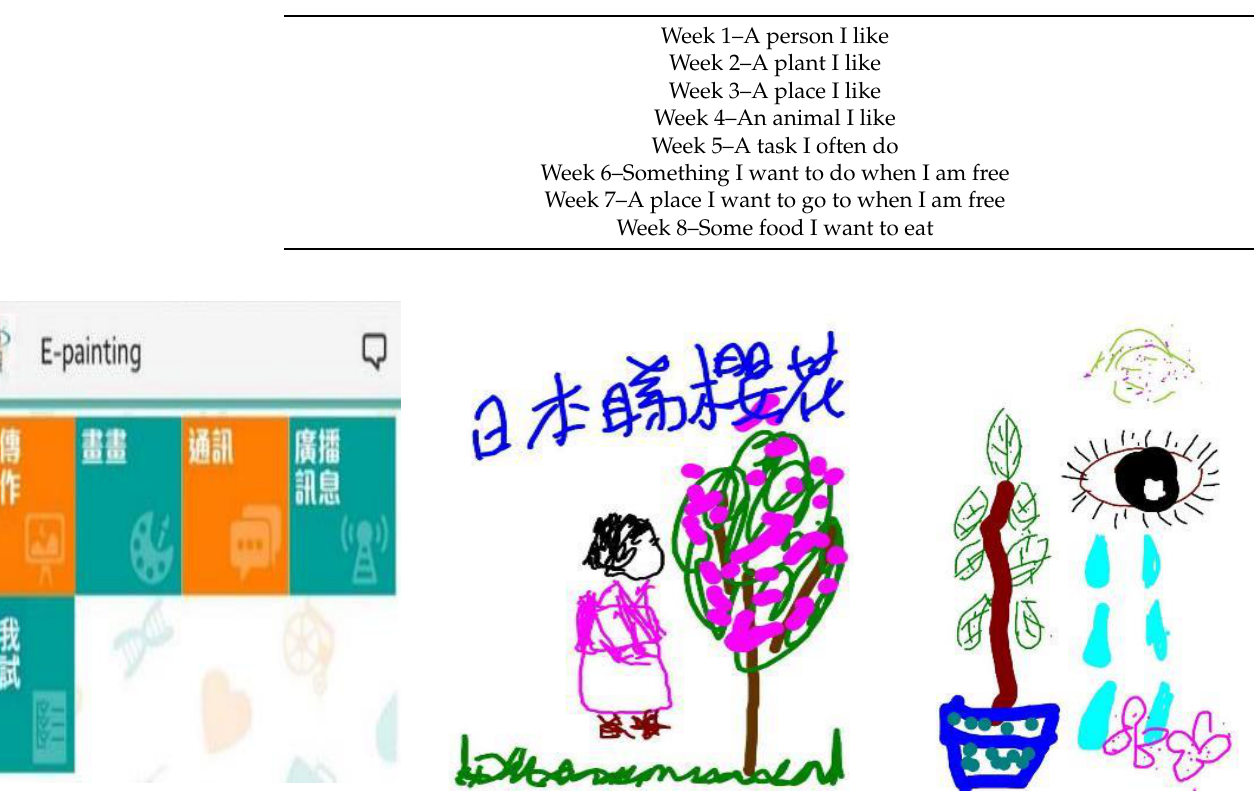
Table A1. Drawing Themes for the 8-week E-painting Intervention St.